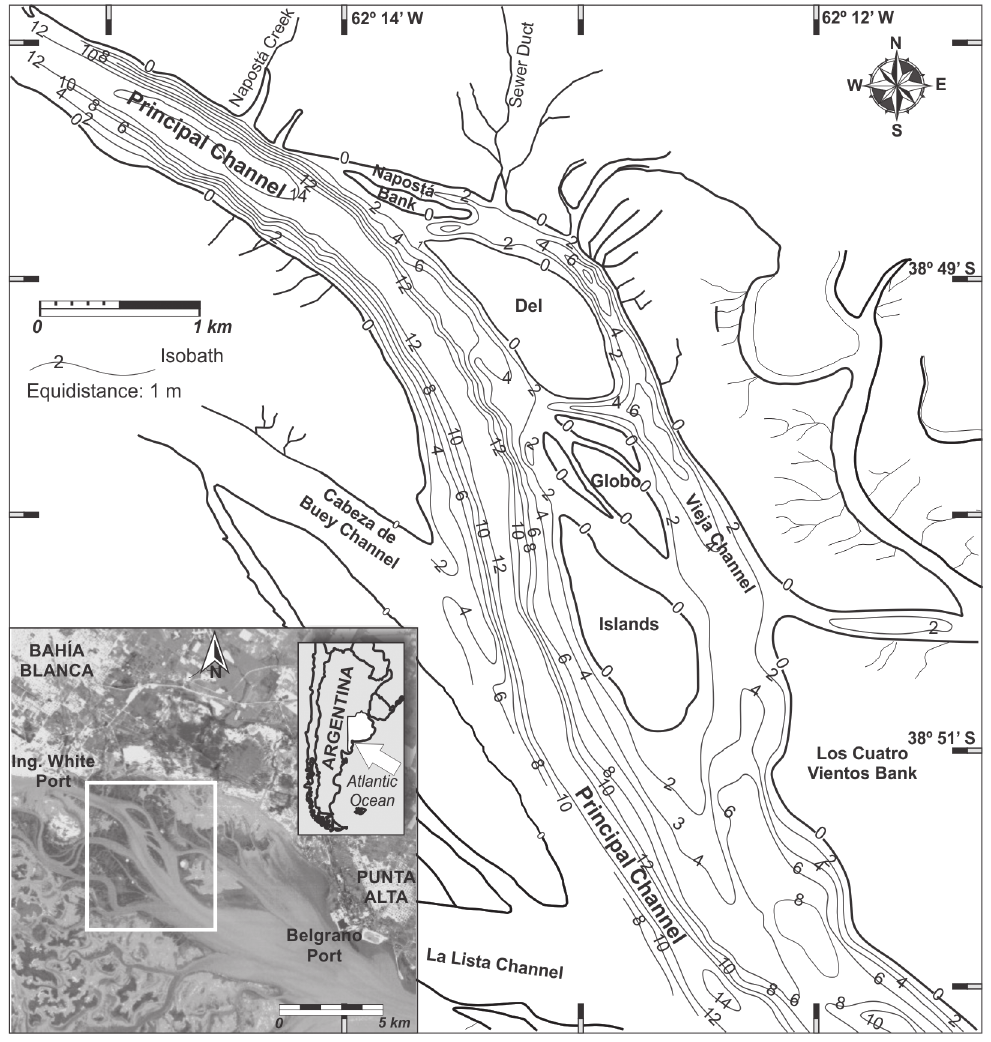
Fig. 1 - Study area. Bahía Blanca